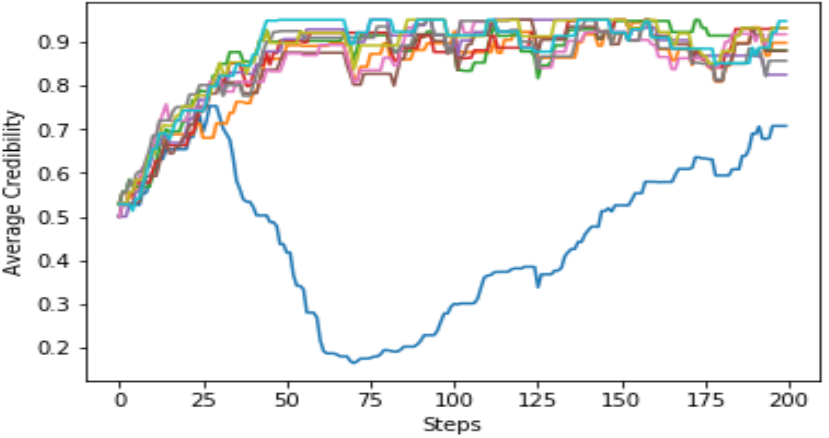
Figure 8. Change in average credibility for each information sharing